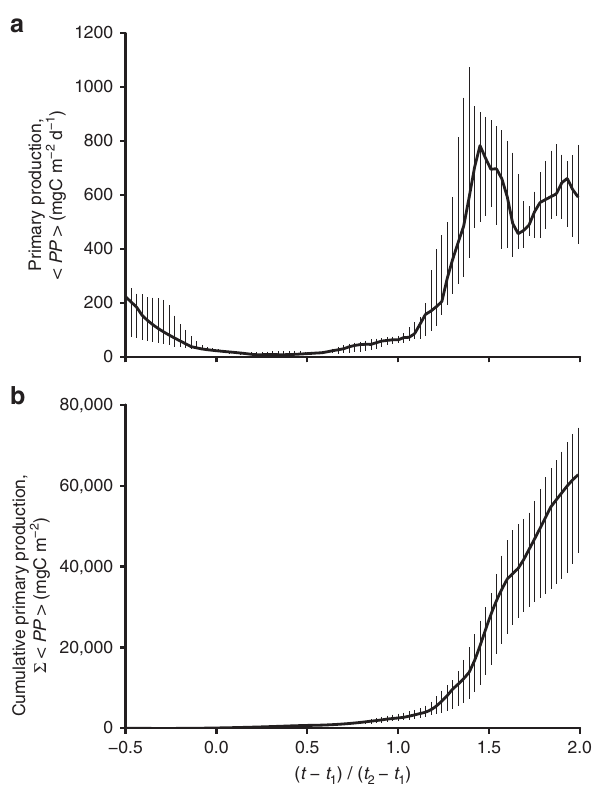
Fig. 4 Phenology of primary production. Same as Fig. 3, but for the daily averaged and depth-integrated primary production, h PP i ( a ) and the cumulative temporal integral of h PP i starting at τ = 0, Σ h PP i ( b